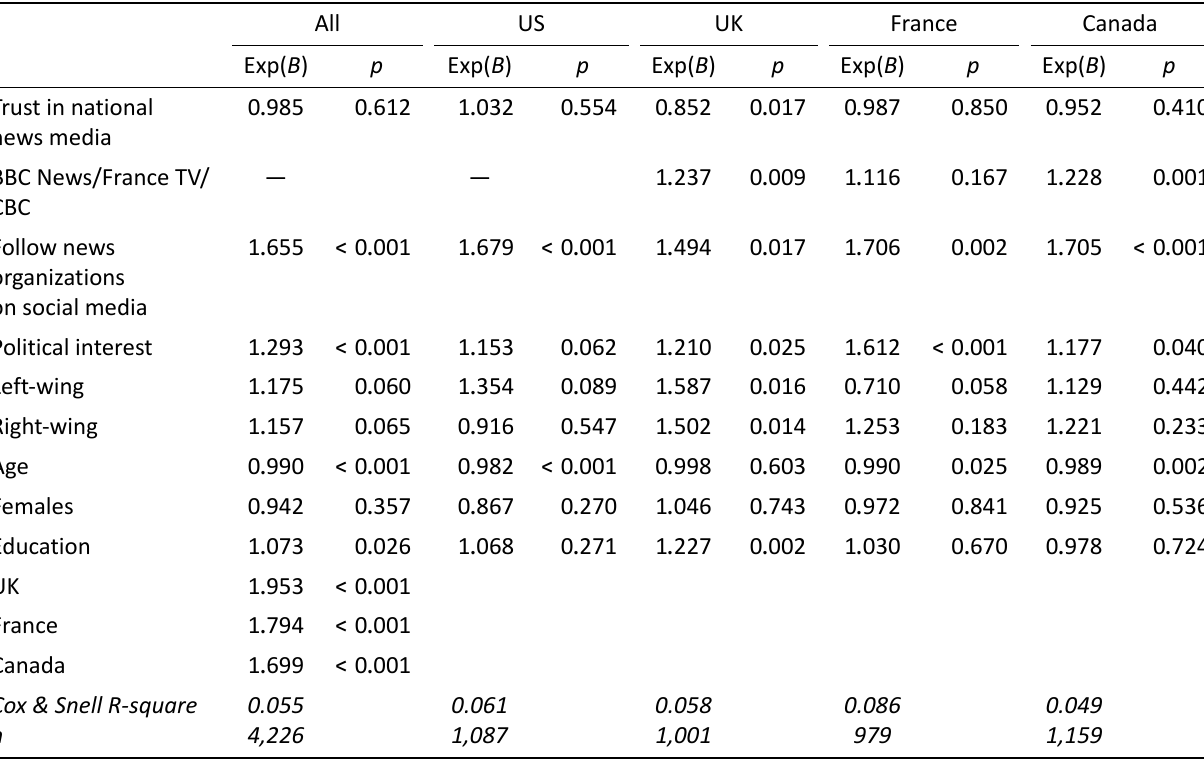
Table 4. Logistic regression of self‐assessed exposure to misinformation about